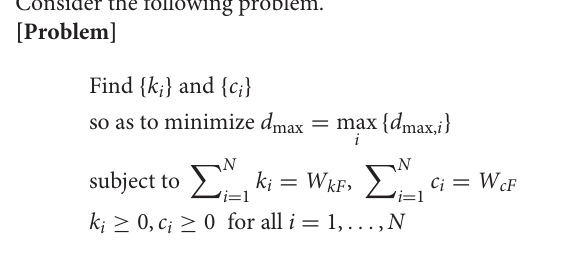
Frontiers in Built Environment |